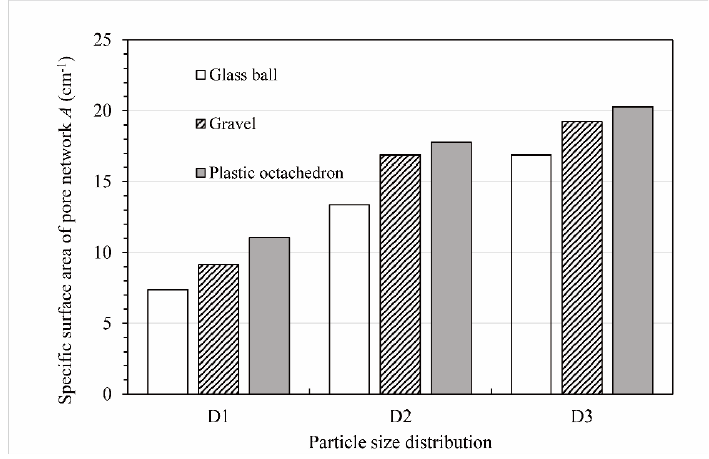
Figure 15. Specific surface area of the pore network ( A ) values of the different packs.